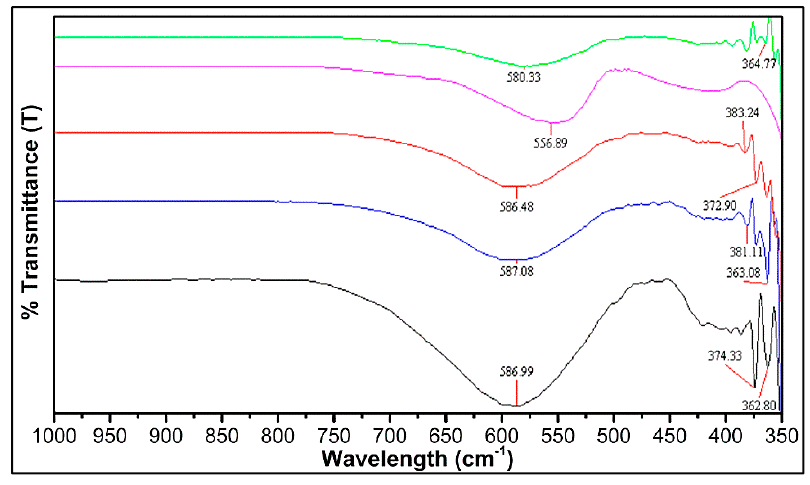
Figure 3. FT-IR spectra of Ni 1 − x Zn x Fe 2 O 4 (x = 0, 0.25, 0.5, 0.75, 1).